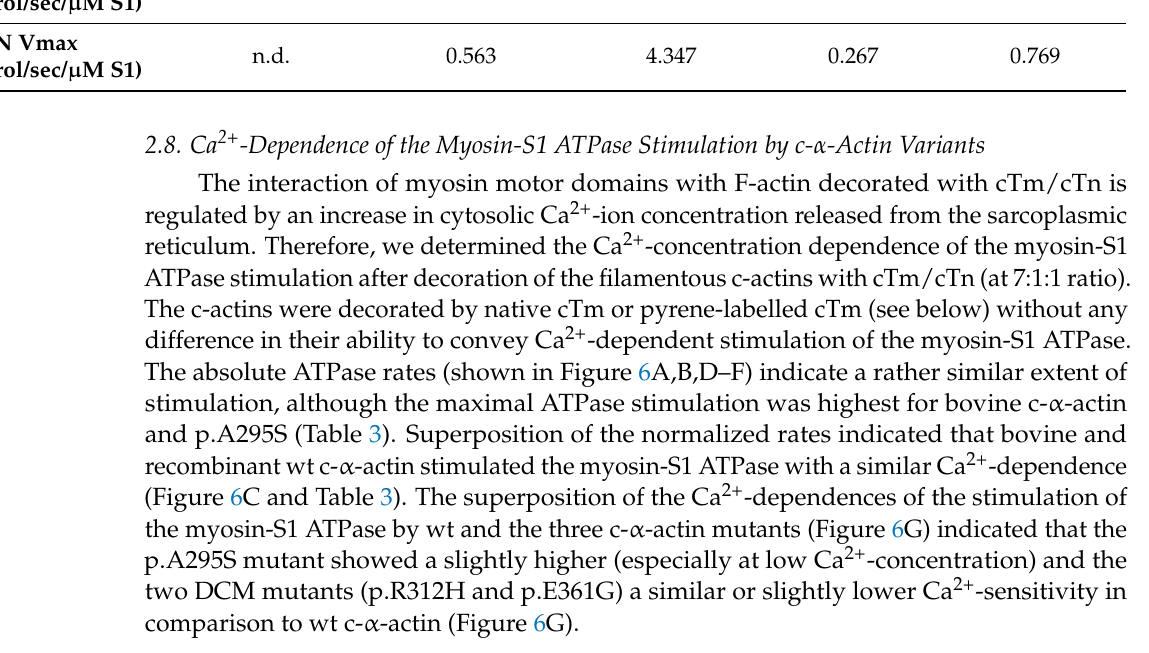
Table 3. Parameters from Ca 2+ -ion dependence of myosin-S1 ATPase stimulation. Parameters were derived from experiments depicted in Figure 5. All measurements were performed for each c-actin variant in filamentous form after decoration with cTm and cTn at a ratio of 6:1:1. Hill coefficients, pCa 50 -values, and the R-squared (R 2 ) values were calculated by the Sigma Plot Systat software (Erkrath, Germany). N gives the number of experiments. Variations are given as SEM. The fold stimulation was calculated from the ratio of the maximal (max.)/minimal (min.) ATPase